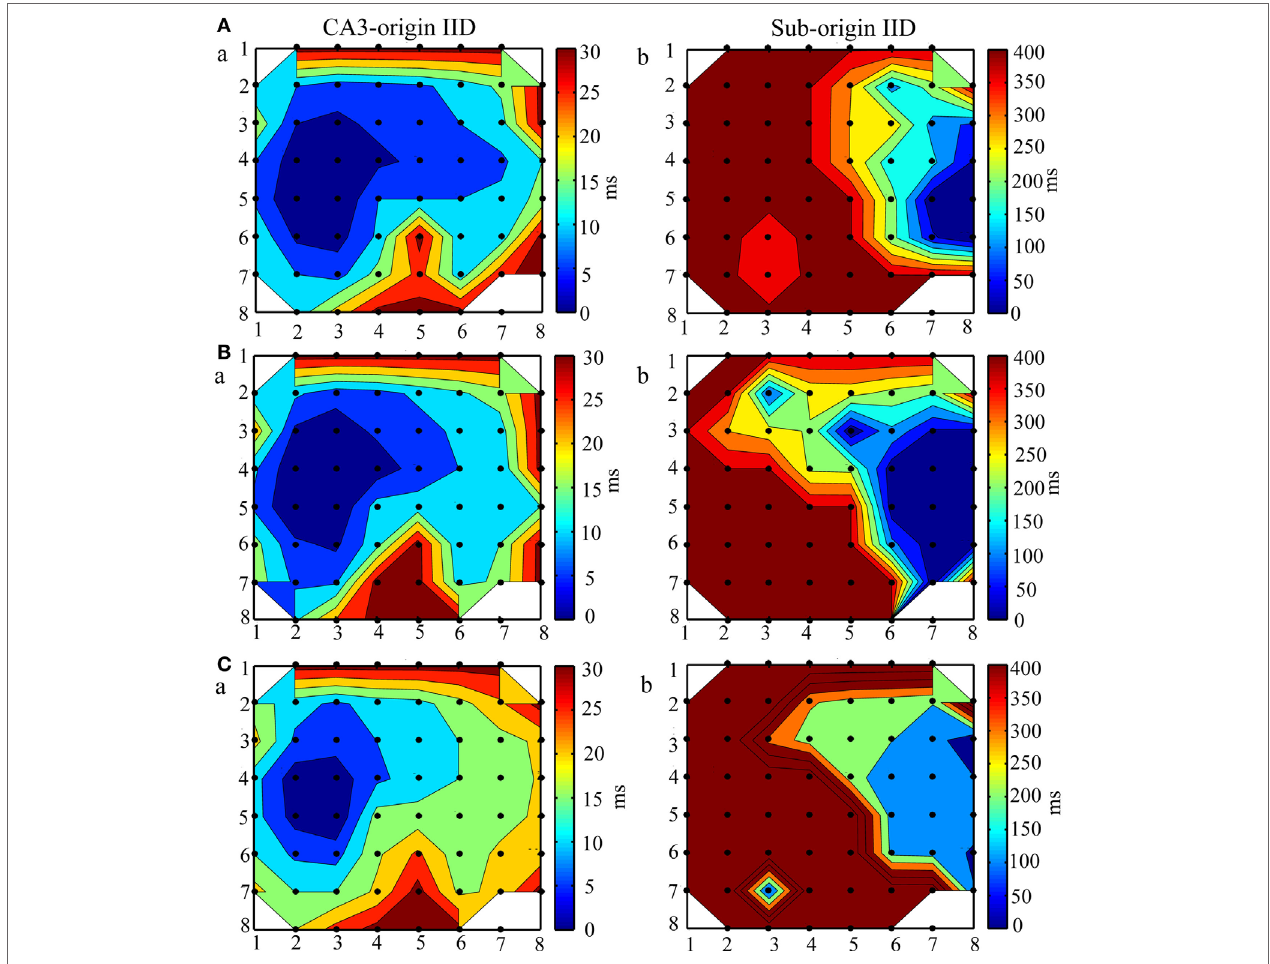
FigUre 7 | The effect of bumetanide upon the initiation and propagation of interictal-like discharges (iiDs) . (a–c) The contour plots for the averaged relative onset-time delays of IIDs before (a) , during (B) , and after (c) bumeatnide application in the slice shown in Figure 5a . The number of the electrodes (black dots) were denoted by the x and y coordinates. The color bar represents the relative onset-time delays. The different color in different regions symboled the initiate sites and propagation pathways. During bumetanide application, the IIDs had two initiations, CA3a/b (Ba) and the subiculum (Bb), the CA3-origin IIDs (Ba) initiated in the CA3a/b, propagated bidirectionally to CA1, subiculum (anterograde) and CA3c, DG (retrograde). The Sub-origin IIDs (Bb) initiated in the subiculum and did not propagate backward to the CA1. The two initiations and two corresponding propagation patterns of IIDs were not significantly different with those before/after bumetanide